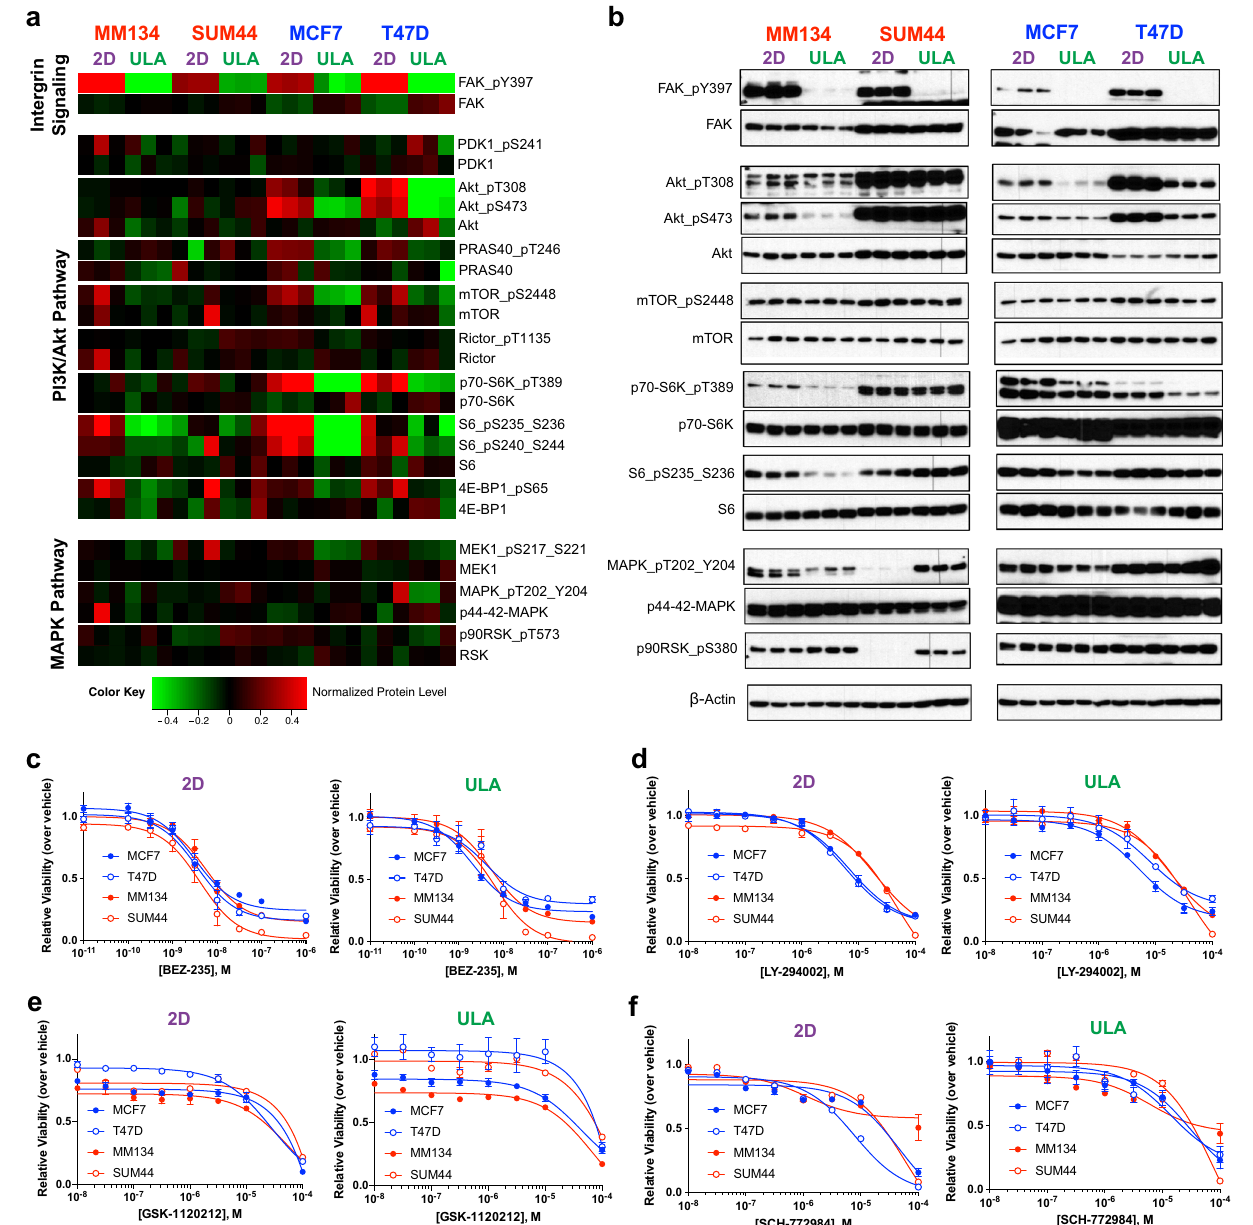
Figure 4. Proteomic profiling and drug treatments of ILC and IDC cell lines in 2D and ULA culture. ( a , b ) RPPA ( a ) and Western blot ( b ) analyses of the ILC (red) cell lines MM134 and SUM44 and IDC (blue) cell lines MCF7 and T47D grown in 2D (purple) or ULA (green) culture for 24 h for the indicated pathways and proteins. Three biological replicates are displayed for each condition. β-Actin was used as a loading control. ( c-f ) Dose response curves of the ILC and IDC cell lines from ( a ) treated with the indicated doses of the ( c ) PI3K/mTOR inhibitor BEZ-235, ( d ) PI3K inhibitor LY-294002, ( e ) MEK inhibitor GSK-1120212 and ( f ) MAPK inhibitor SCH-772984 in 2D (purple; left) or ULA (green; right) culture after 4